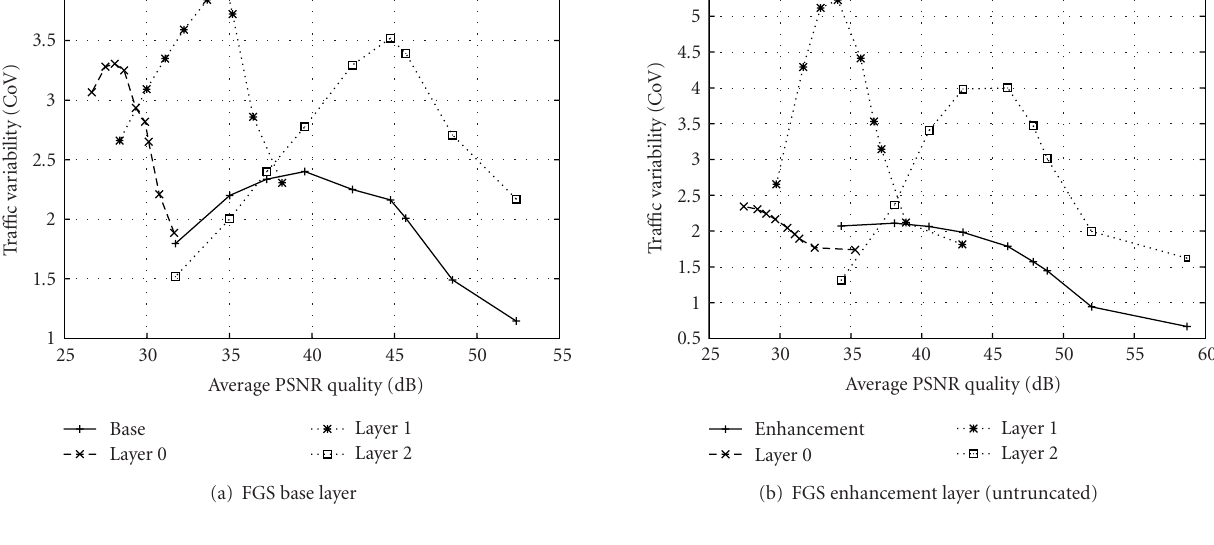
compared with equivalent MPEG-4 Part 2 scalable